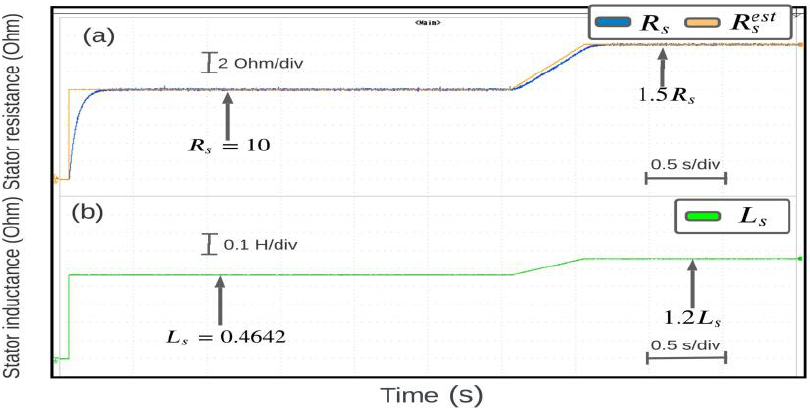
Figure 15. The stator parameters ( a ) stator resistance; ( b ) stator inductance.